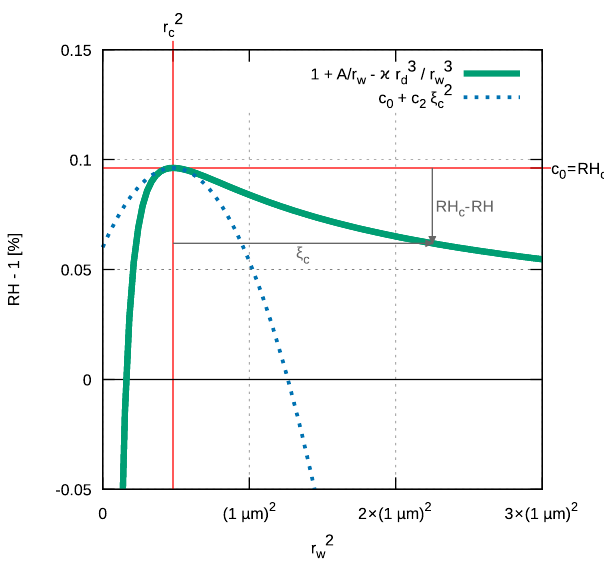
Figure 3. Activation timescale as a function of dry radius and rela- tive humidity estimated with Eq. (8) with A ∼ 10 − 3 µm, κ = 1 .